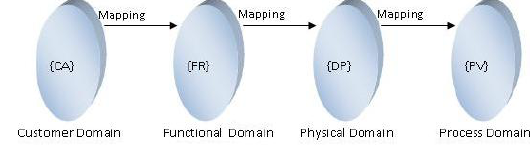
Figure 1. Design mappings and